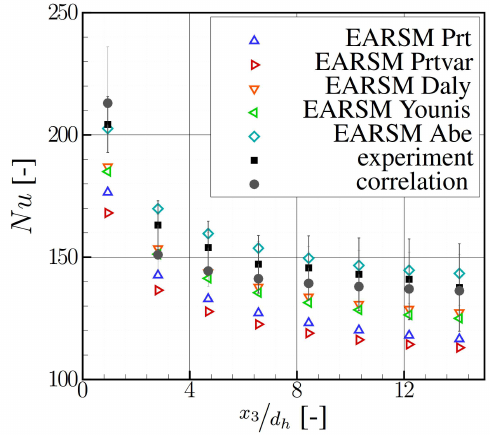
Figure 5. Nusselt numbers over normalized length, experimental data, different models of turbulent heat flux, semi-empirical correlation